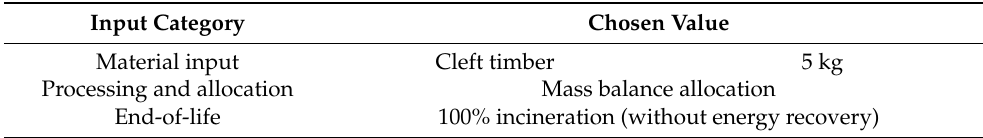
Table 1. Chosen values for the non-variable parameters of the